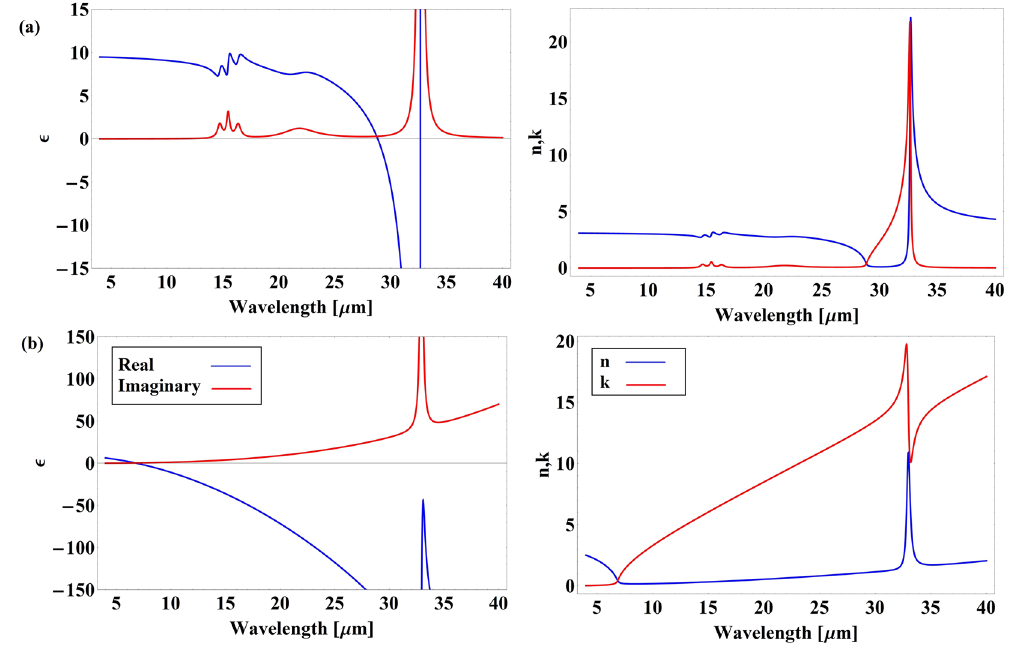
Figure 2. Real and imaginary parts of the permittivities and refractive indices of ( a ) semi-insulating InP and ( b ) InP:Si.